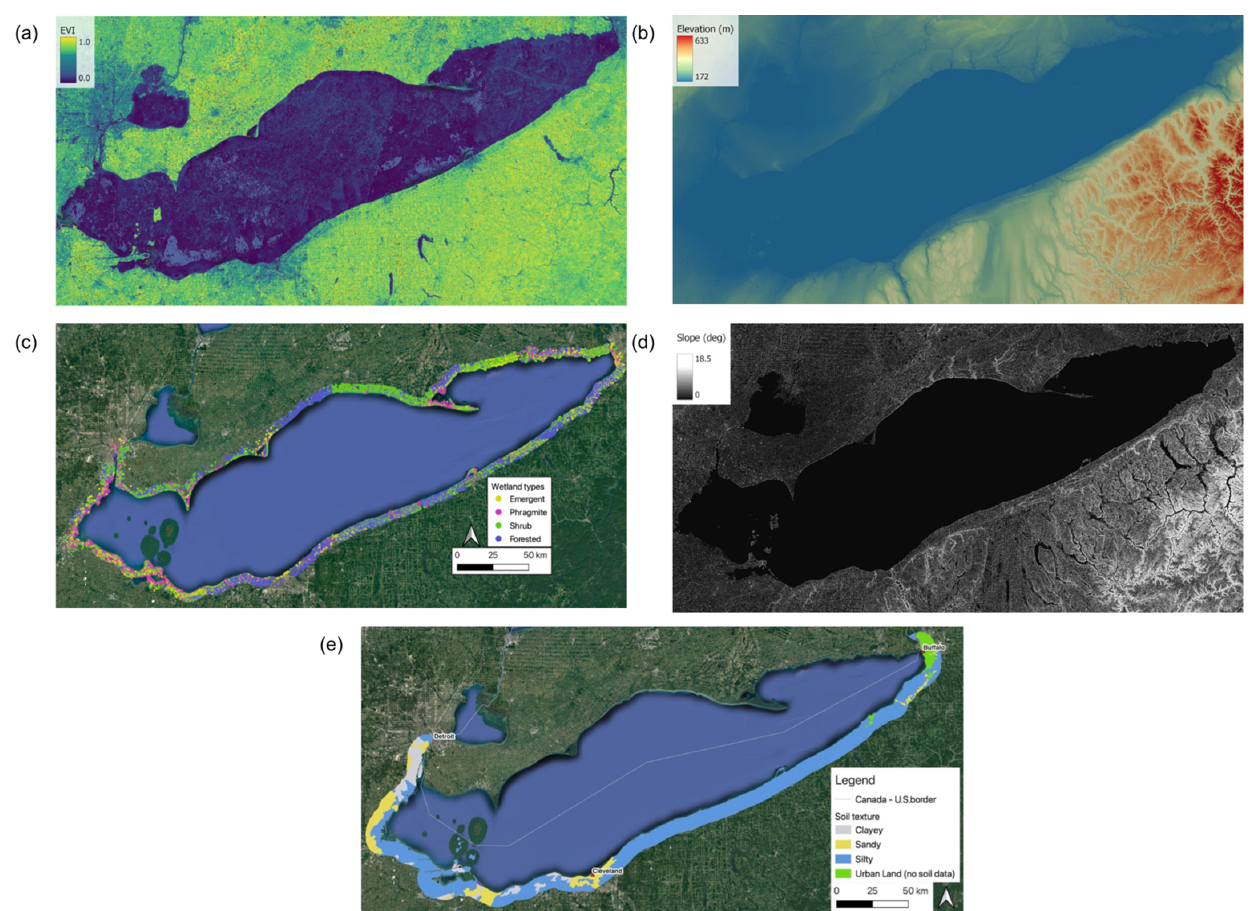
Figure 2. Spatial data layers used for the study: ( a ) EVI (used as proxy for plant productivity); ( b ) elevation; ( c ) wetland land cover; ( d ) slope; ( e ) soil texture.